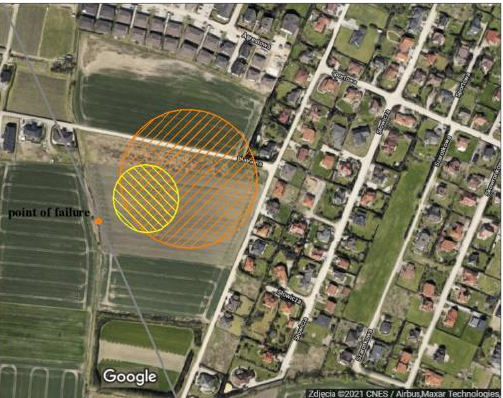
( b ) Figure 19. Hazard zones due to a jet fire ( a ) and an explosion ( b ) for a natural gas pipeline (a = 0.2, p = 1 MPa). As already mentioned, the negative effects of a fire or an explosion of natural gas released from the pipeline are much more dramatic when the pipeline is located in pop- ulated areas. Examples of such a hypothetical localisation of the gas leakage are pre- sented in Figures 20–24. The hazard zones arising due to the heat flux generated from a fire caused by natural gas released from an example pipeline are shown in the figures below. The distance of the failure site from built-up areas is approximately 150 m. The zones marked in yellow and orange indicate the range within which the heat flux value causes human death. In the analysed scenario for a pipeline with a diameter of 0.5 m, partial damage is assumed (a = 0.2) with gas pressure values of 5 MPa (orange) and 1